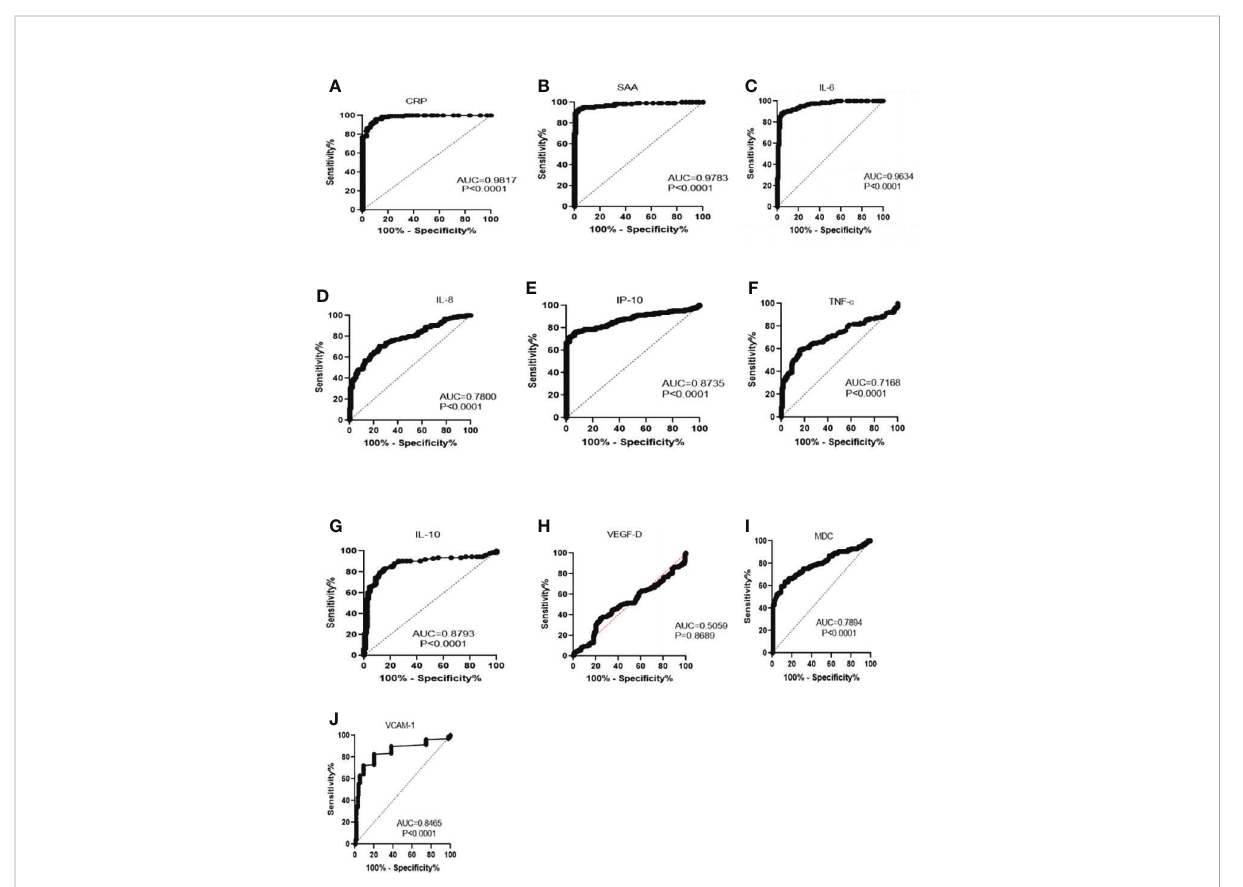
FIGURE 1 Receiver operating characteristics analysis of healthy control subjects versus COVID-19 patients, using speci fi c biomarkers (A) CRP, C-reactive protein. (B) SAA, serum amyloid A (C) IL-6, interleukin 6. (D) IL-8, interleukin 8. (E) IP-10, interferon- g -inducible protein-10. (F) TNF- a , tumor necrosis- a . (G) IL-10, interleukin-10. (H) VEGF-D, vascular endothelial growth factor-D. (I) MDC, macrophage-derived chemokine (MDC). (J) VCAM-1, vascular cell adhesion protein